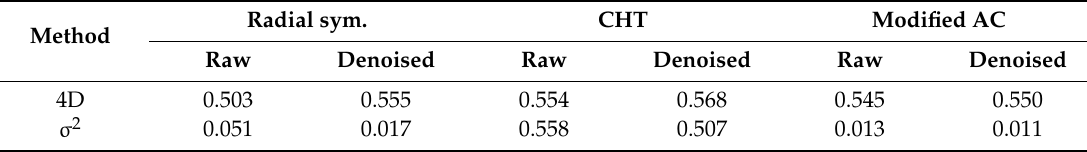
Table 1. The di ff usion coe ffi cient D and the square of mean localization error σ 2 for the 3 di ff erent tracking